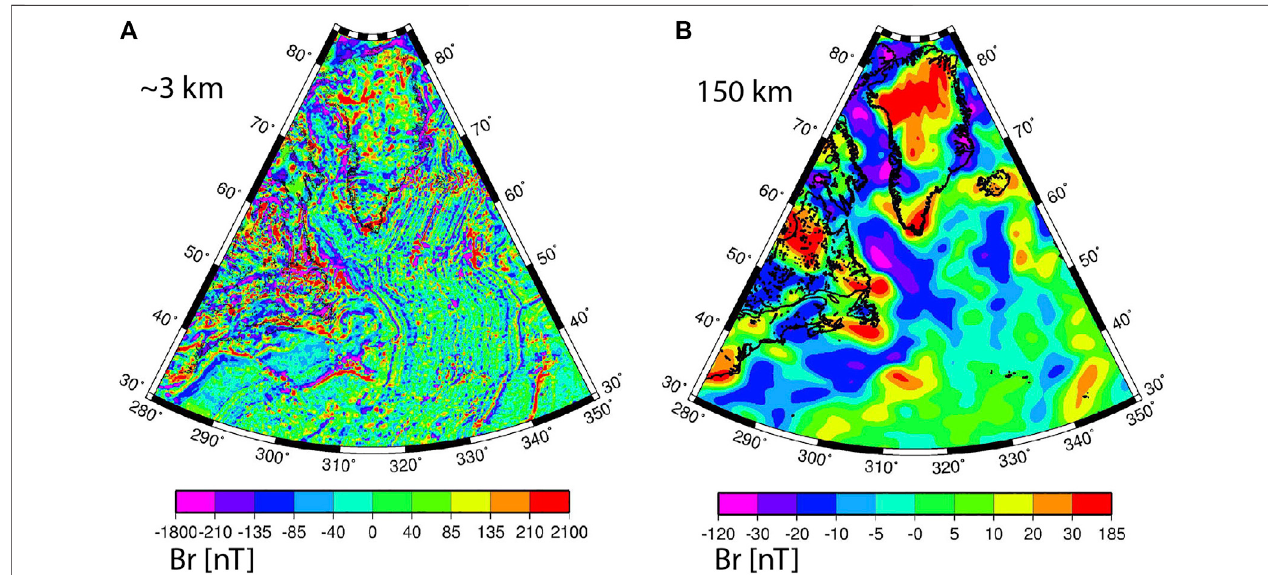
FIGURE7| Theradialcrustalmagnetic fi eldofthemid-oceanicridgeonEarthasseen (A) justabovethesurface (B) andfrom150 kmaltitude.AdaptedfromRavat (2011).